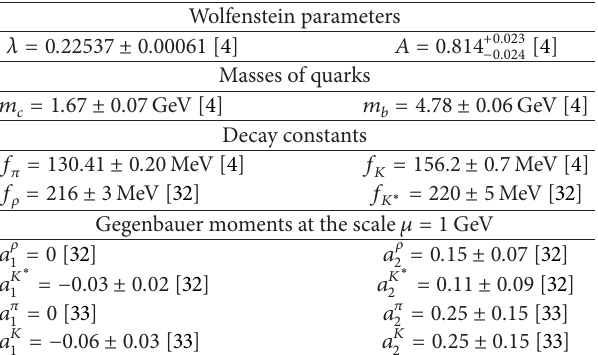
Table 3: The values of input